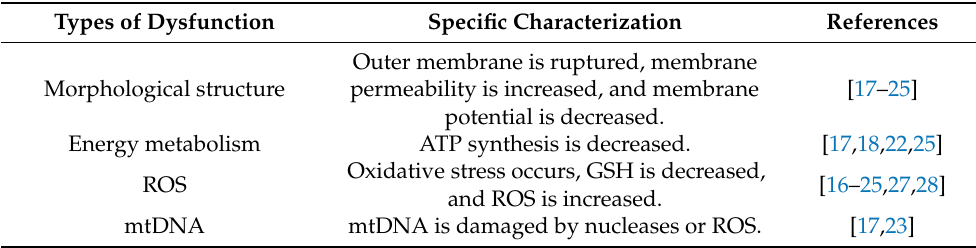
Table 1. Characterizations of mitochondrial dysfunction in